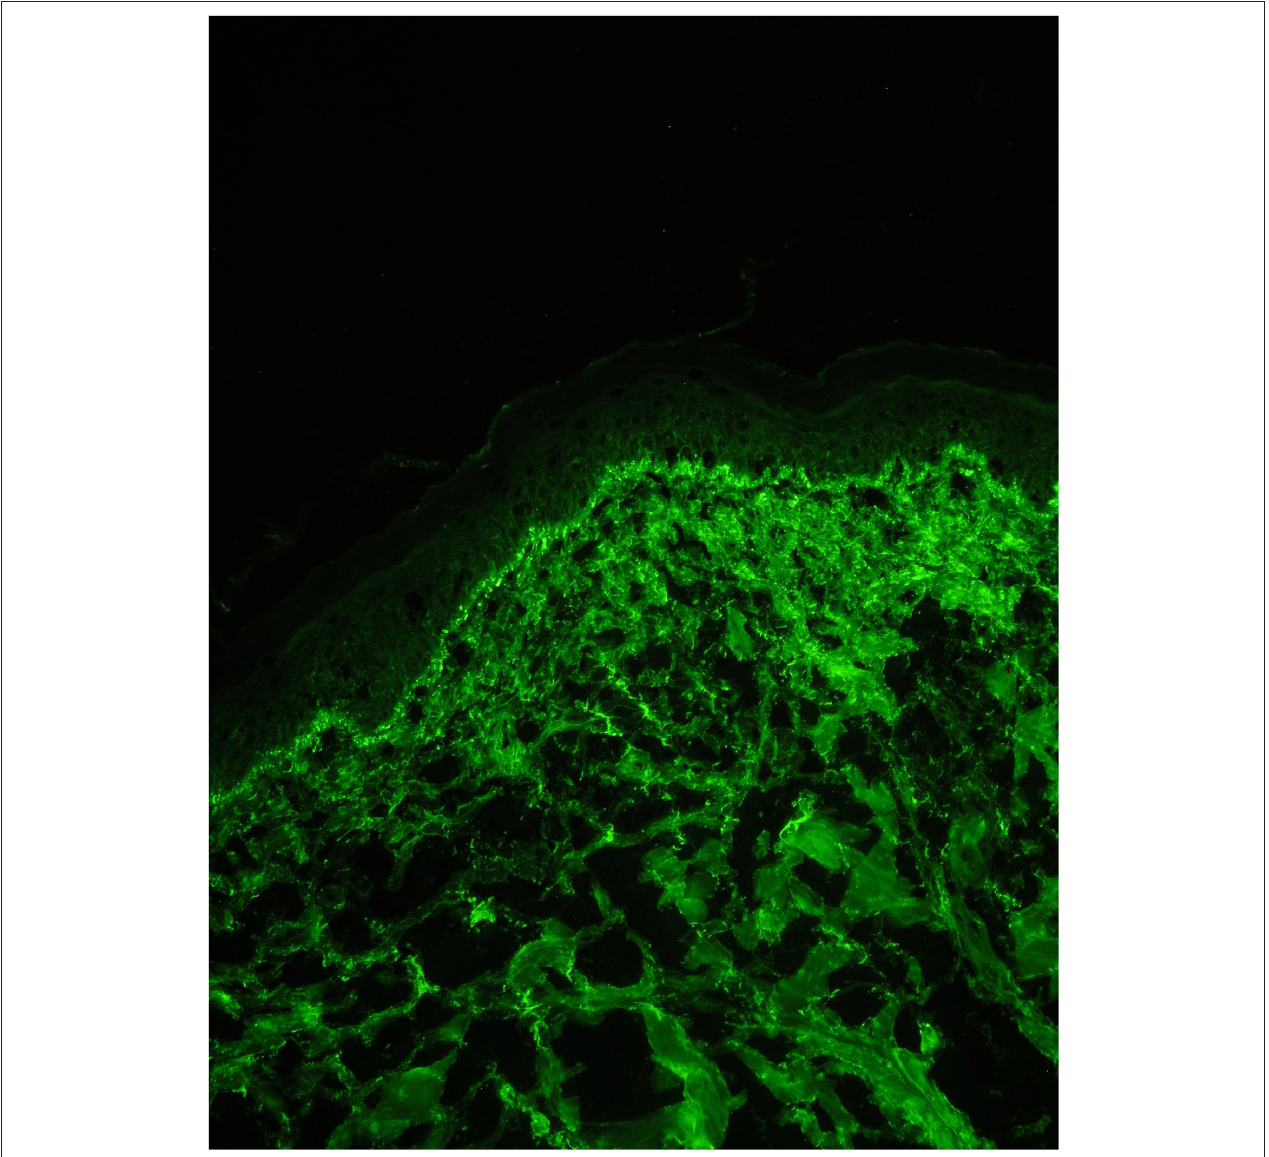
FIGURE 4 | Direct immunofluorescence on a biopsy from a lesion on photo exposed skin showing a granular band of immuno-reactant deposition along the dermal-epidermal junction.